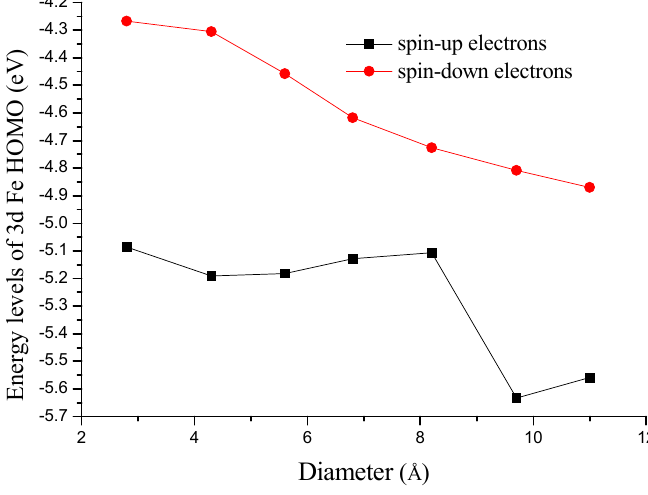
Figure 6. Calculated energy levels of Fe 3d HOMO with the increasing of tube diameter.